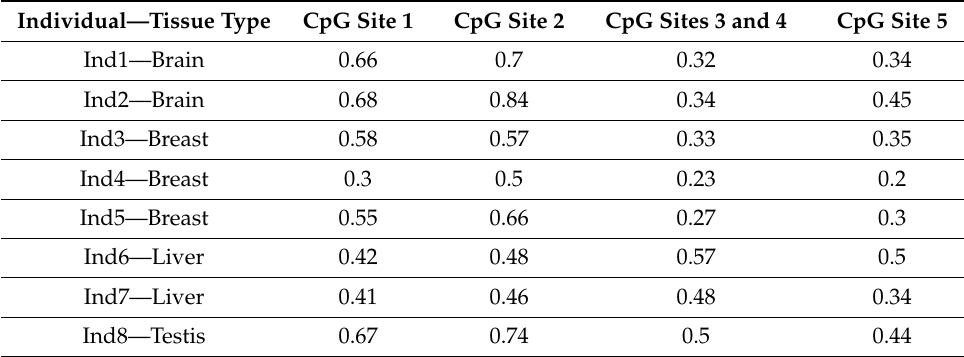
Table 1. Methylation of the 5 consecutive CpG sites in the KCNK9 -US1